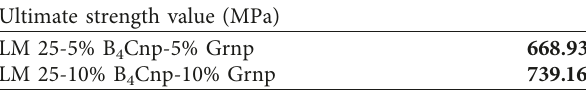
Figure 9: Microtensile test result of LM 25-B composites. Table 3: Ultimate strength value (N/mm 2 ).